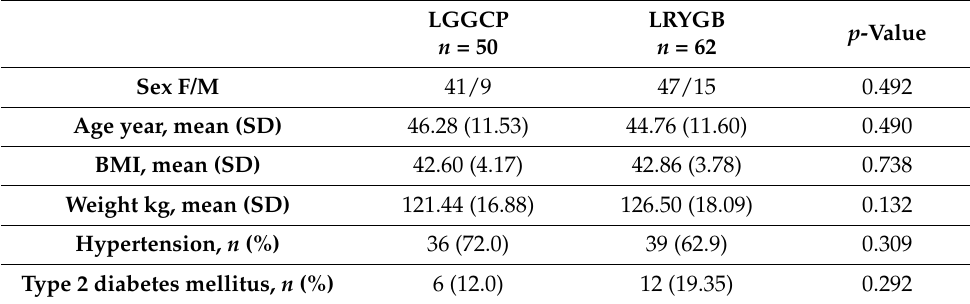
Table 1. Baseline characteristics of the patients included in the study.